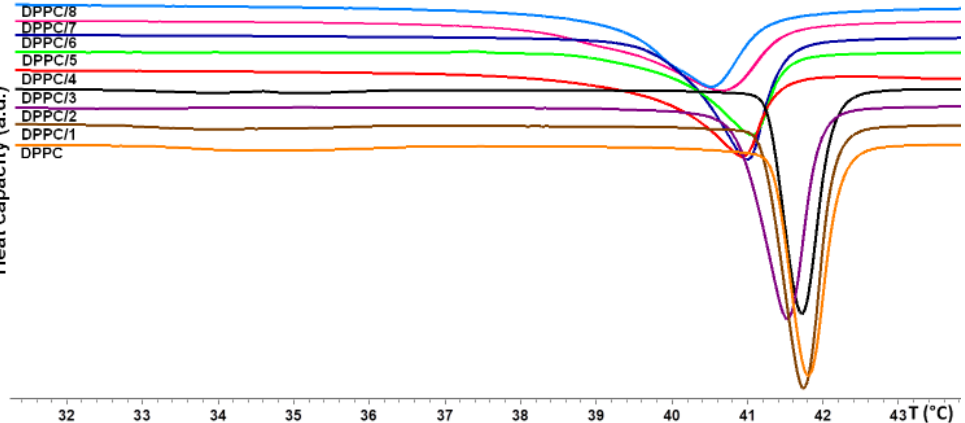
Figure 9. Thermograms of DPPC/quinolines MLV: DPPC, yellow line; DPPC/ 1 , brown line; DPPC/ 2 , purple line; DPPC/ 3 , black line; DPPC/ 4 , red line; DPPC/ 5 , green line; DPPC/ 6 , blue line; DPPC/ 7 , pink line; DPPC/ 8 , light blue line. Scan rate is 1 °C/min.